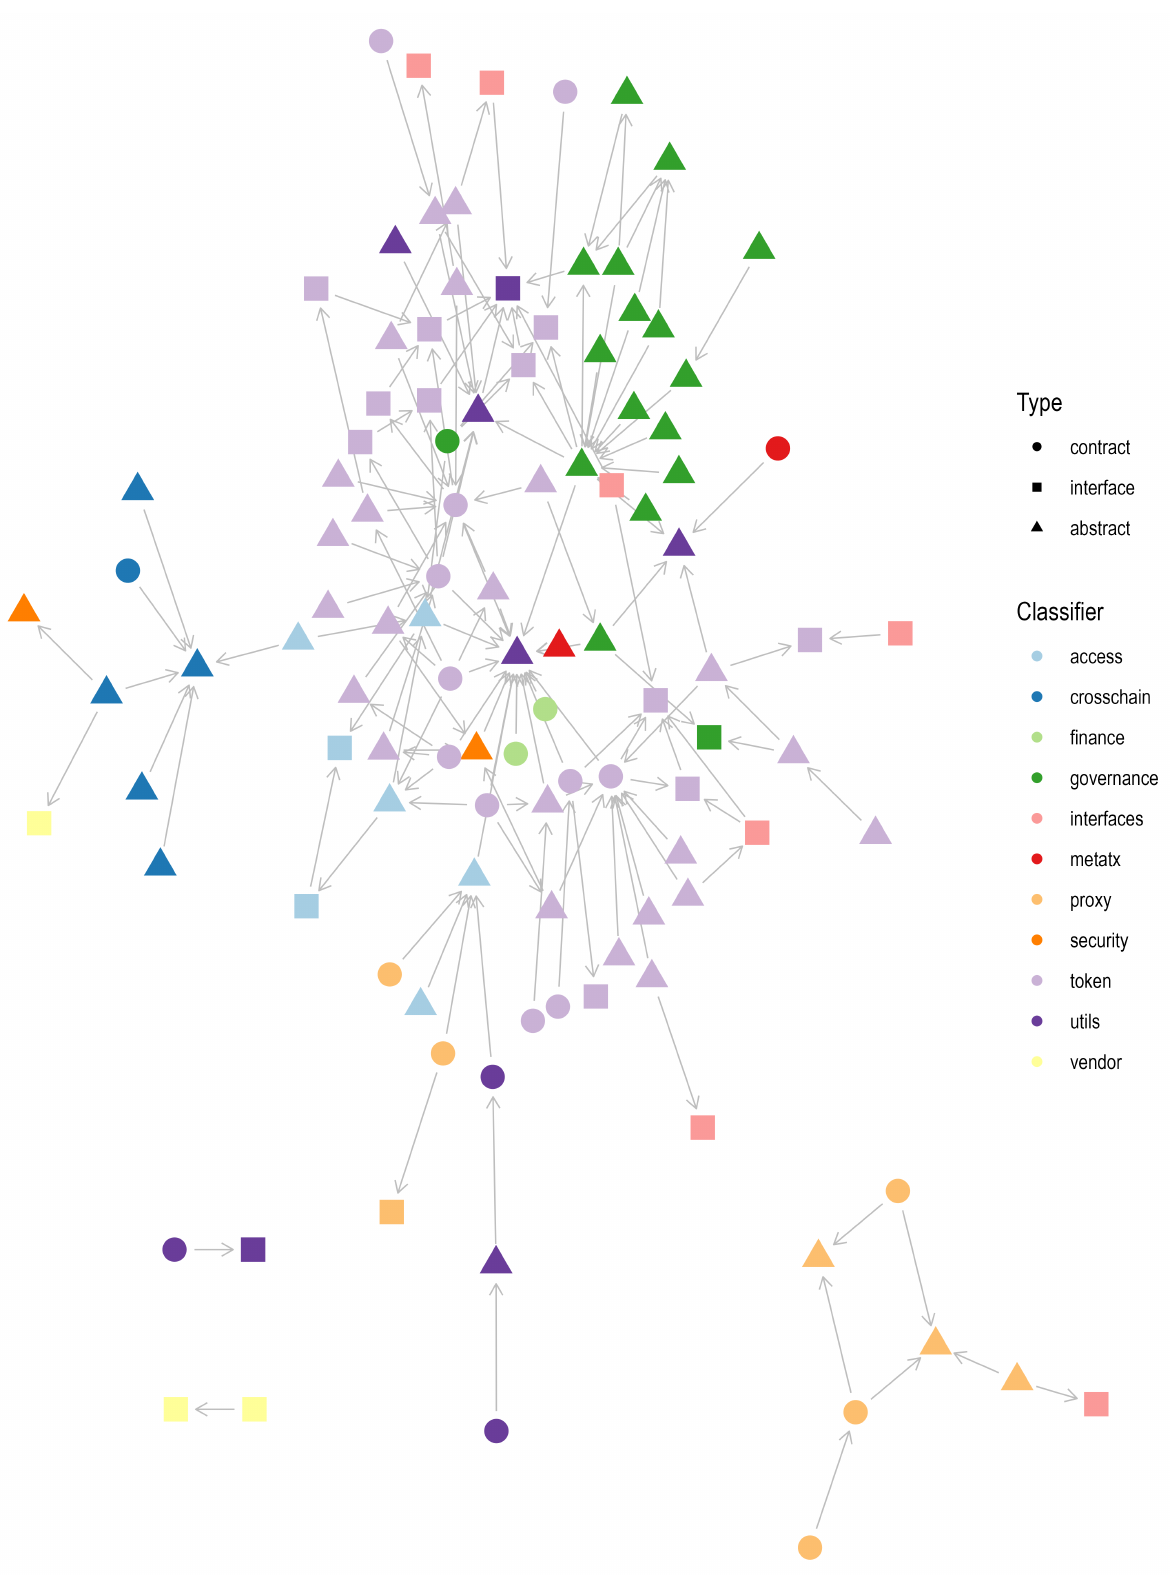
Figure 4. Inheritance of OpenZeppelin components containing contract types: (i) contracts, (ii) inter- faces, and (iii) abstract contracts. Libraries have not been visualized. The most dominant classifiers are tokens, governance, and